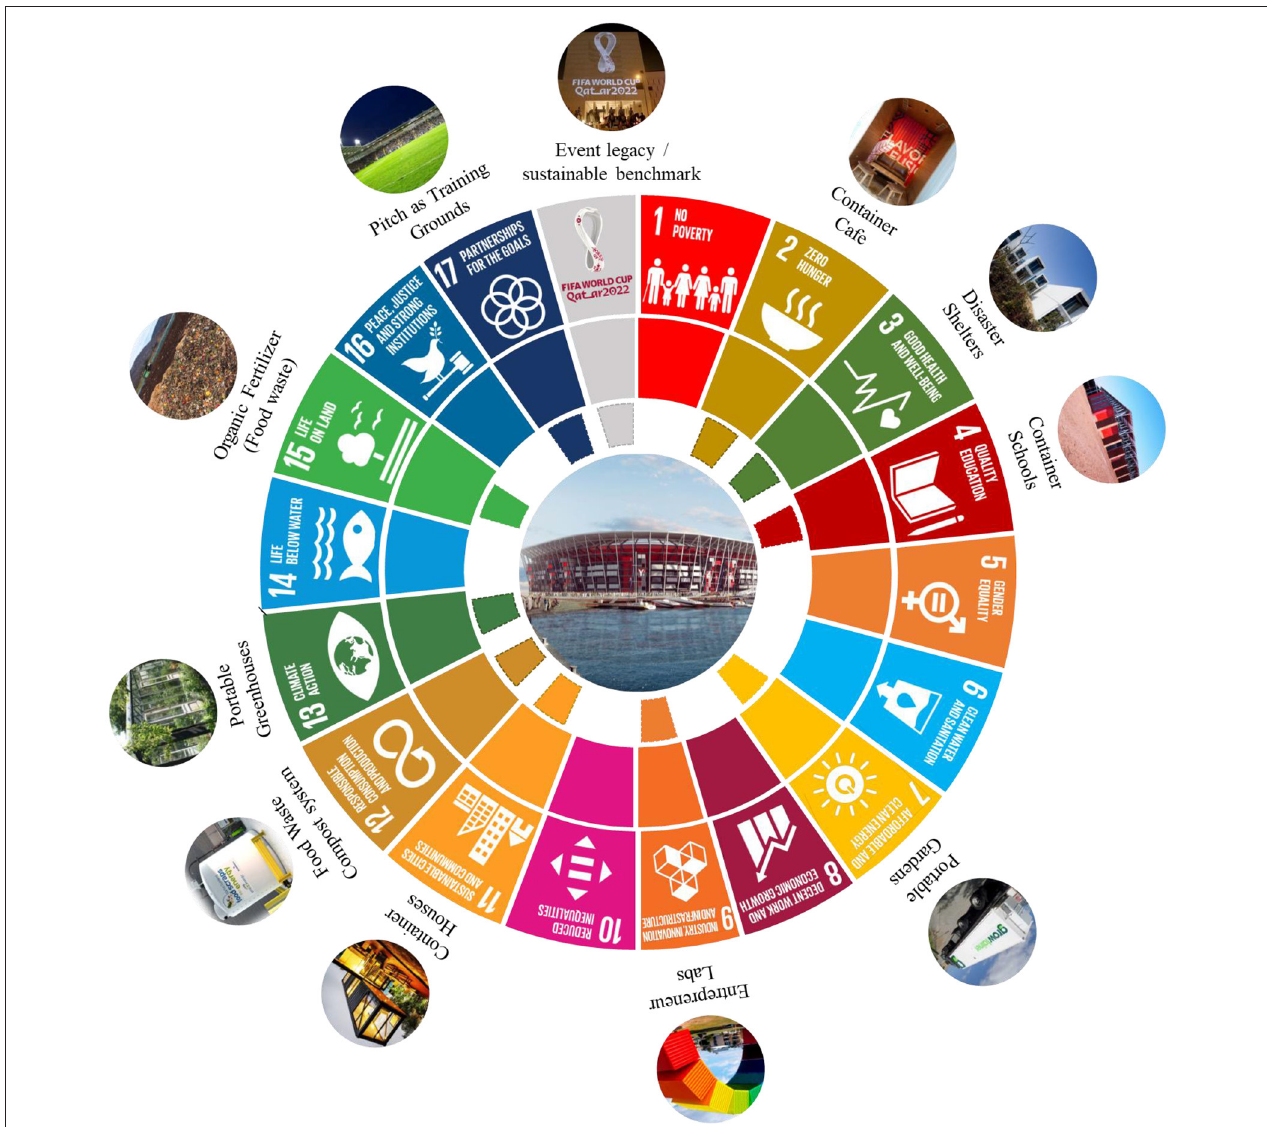
FIGURE 8 | Benefits of modular stadium design to leverage ecological burden, aligned to UN SDGs and LOC